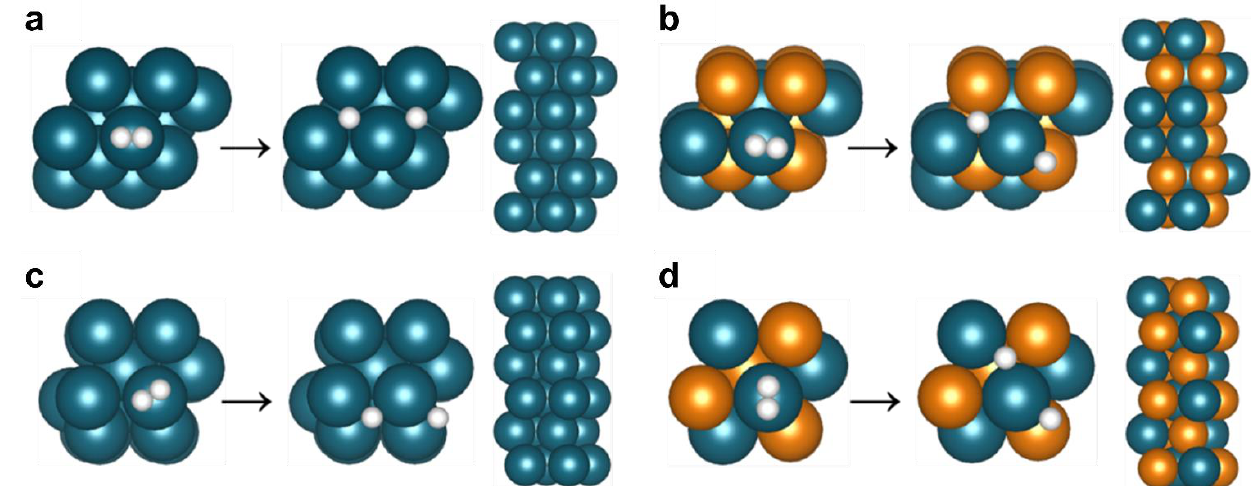
Figure 10. Top view for H 2 dissociation and side view of slab models; ( a ) FCC Pd (111), ( b ) FCC PdCu (111), ( c ) BCC Pd (110), and ( d ) BCC PdCu (110). The teal, orange, and white balls denote the Pd, Cu, and H atoms, respectively. Table 2. Calculated adsorption energies of H 2 and activation energies for H 2 dissociation reaction